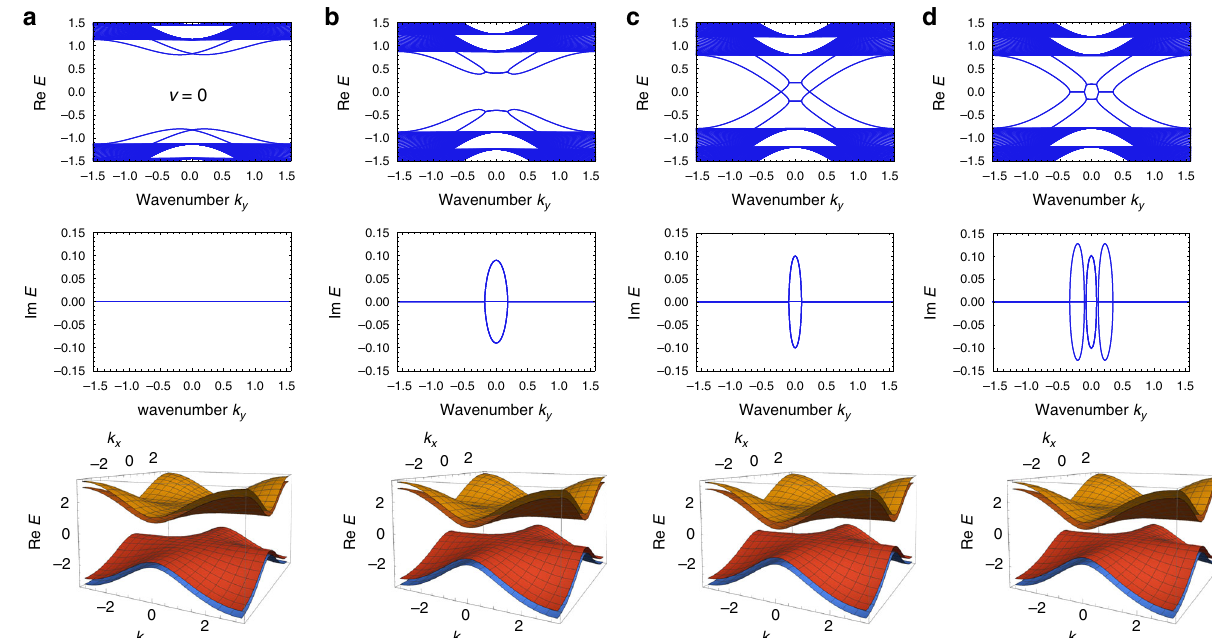
Fig. 2 Emergent exceptional edge modes through a non-Hermitian coupling. a – d Non-Hermiticity is increased from a to d . The upper two fi gures show the real and imaginary parts of the edge dispersions. The lowest fi gure represents the bulk band structure of the homogeneous system under the periodic boundary conditions. We set the parameters u = − 1, c = 0.2, and γ = 0.8 throughout the calculations in this Figure. a Without non-Hermitian coupling ( β ¼ β 0 ¼ 0), there is a large energy gap even in the edge band structure. Therefore, the bulk topology is trivial in this Hermitian system. b With increased non-Hermiticity ( β = 0.81, β 0 ¼ 0 : 63), the upper and lower edge dispersions approach to each other. c At the critical strength of the non-Hermitian coupling ( β = 0.9, β 0 ¼ 0 : 7), the upper and lower edge dispersions coalesce. However, there are no gap closings in the bulk band structure. Thus, the bulk topology should remain trivial. d With a stronger non-Hermitian coupling than the critical value ( β = 0.909, β 0 ¼ 0 : 707), pairs of EPs appear. These edge modes are robust against disorder and thus exceptional edge modes robustly appear even with trivial bulk